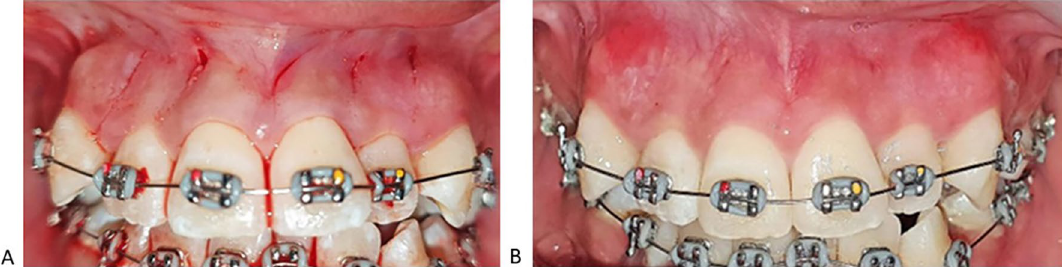
Figure 2. Piezocision flapless corticotomy procedure ( A ) Immediate after piezocision surgery, ( B ) Healing response after 1 week of